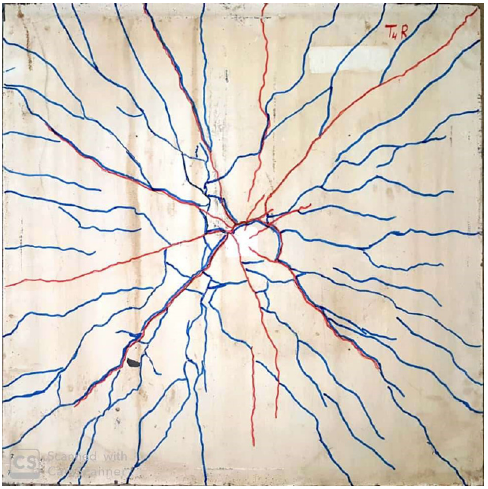
Figure 14: Crack pattern under impact - fl exural loads of the T4SS2 slab bottom face.